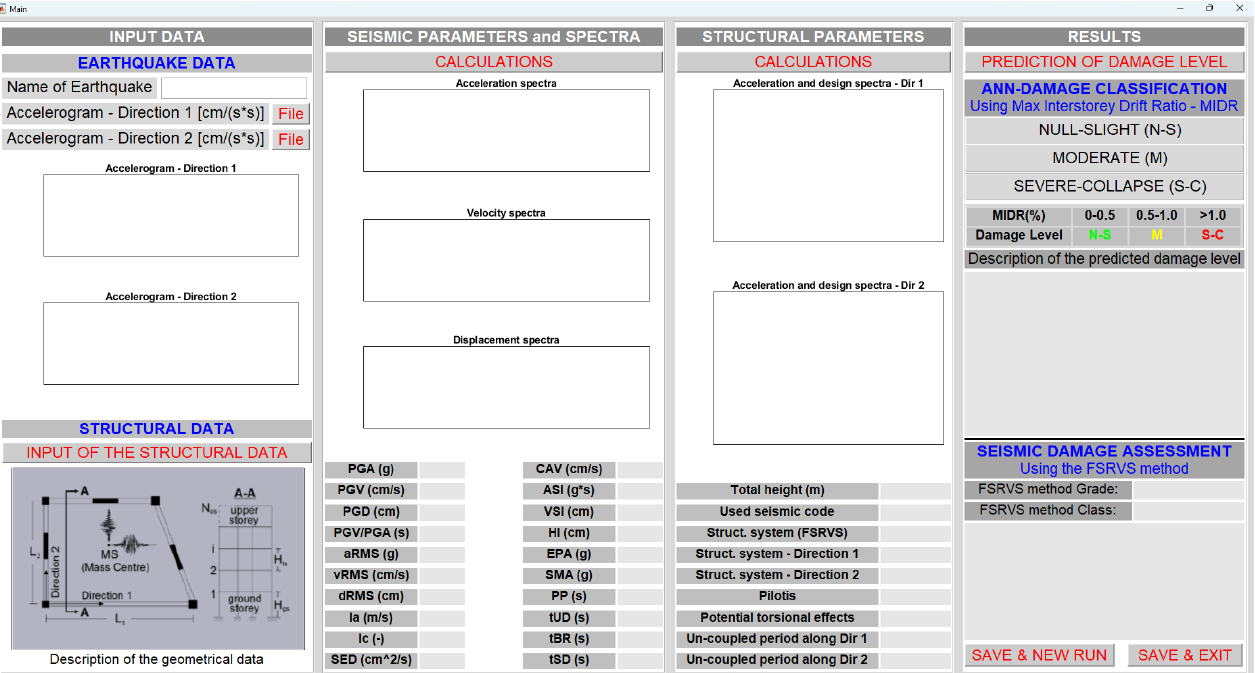
Figure 4. Main window of the proposed application (before the insertion of the input